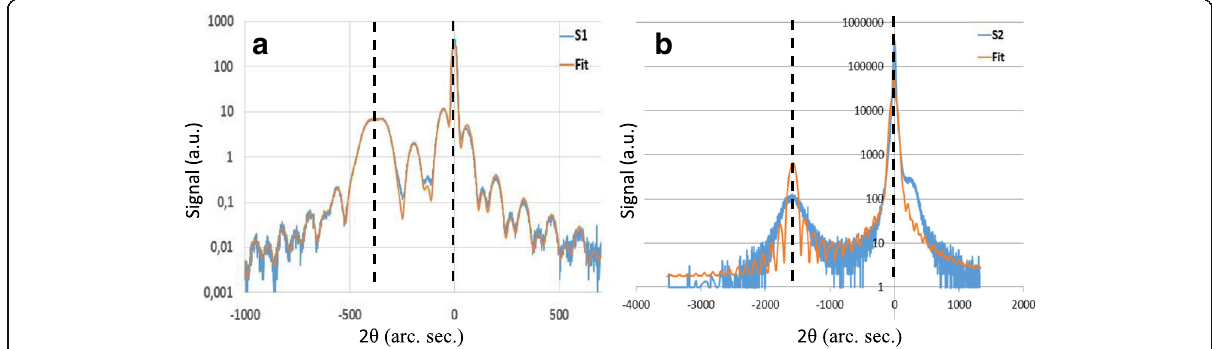
Fig. 5 X-ray diffraction data (blue lines) and simulated fits (orange lines) of sample S1 ( a ) and sample S2 ( b ). Vertical dashed lines highlighting the GaAs peak at 0° arc seconds and the GaAsBi film peak located at negative arc seconds. The shoulder on the right GaAs peak in Fig. 5b is indicative of a GaAs cap layer under tensile